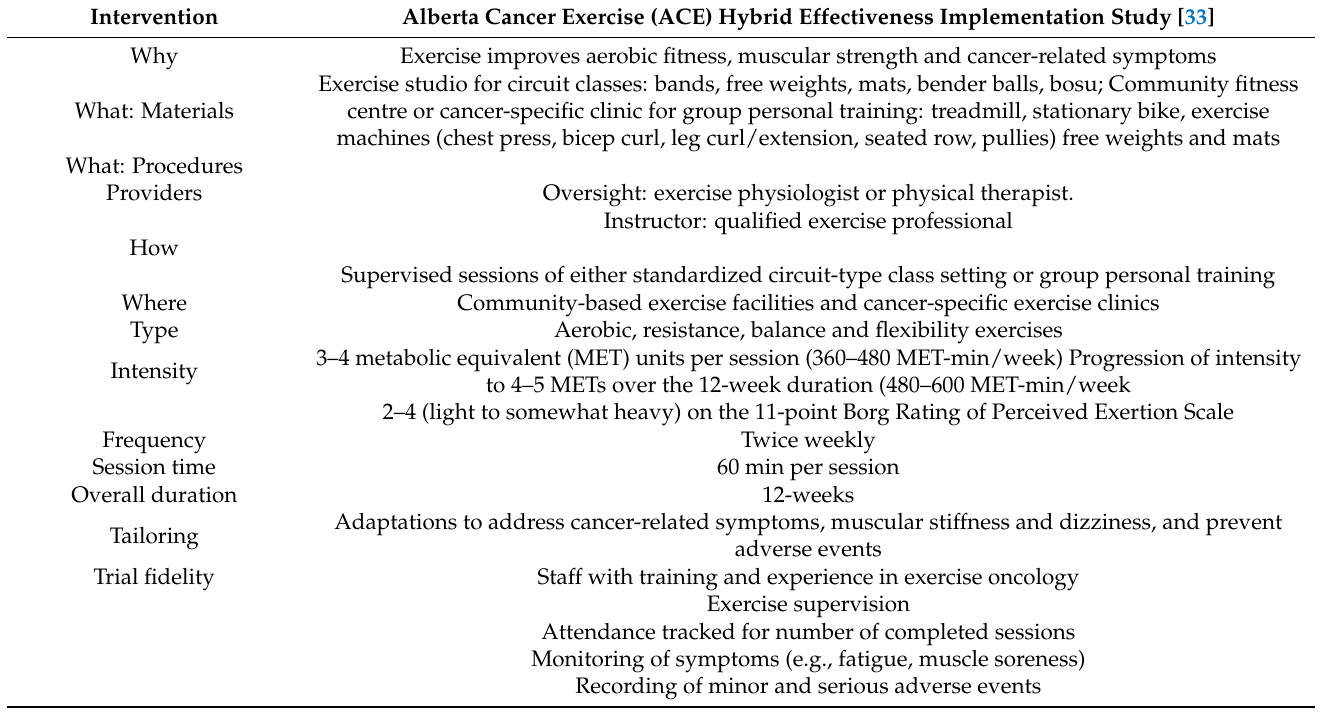
Table 1. Intervention description using the template for description and replication checklist